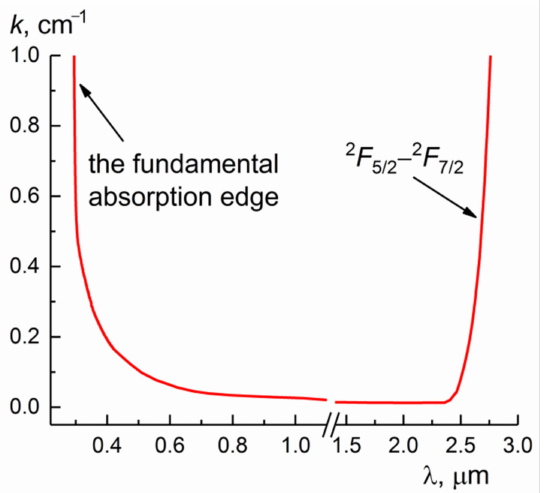
Figure 3. The RT absorption spectrum of a c -axis-oriented CeF 3 single